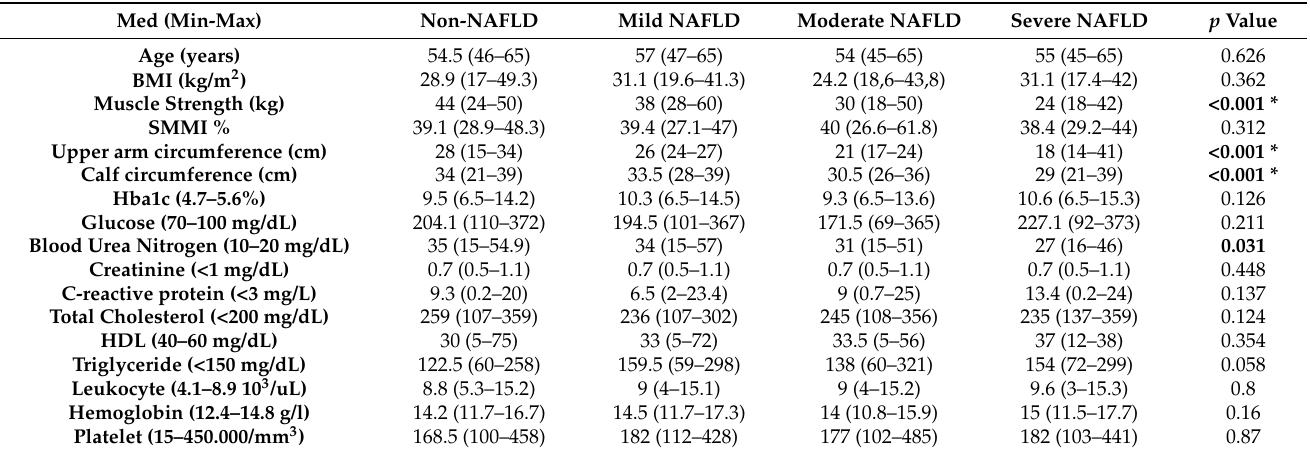
Table 2. Review of demographic, body and muscle measurements and laboratory features of the patients according to NAFLD